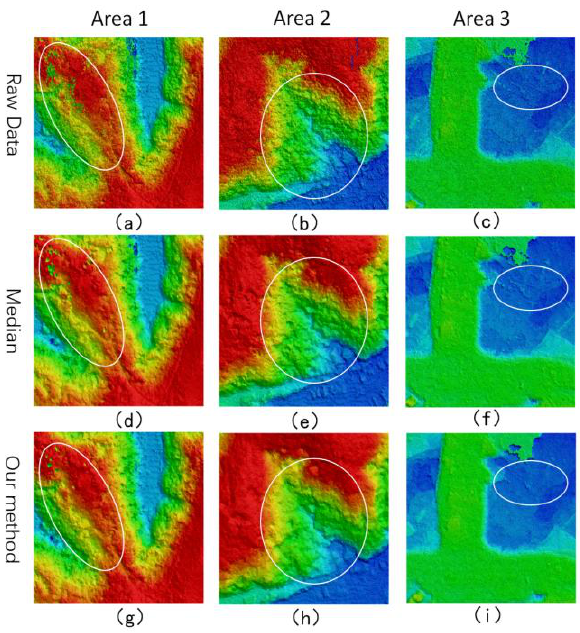
Figure 9. Comparison of median of grid cell and our method. (a), (b) and (c) are the raw data from dataset 1 and dataset 2; (d), (e) and (f) are the results of median of grid cell and TIN algorithm; (g), (h) and (i) are the results of the proposed